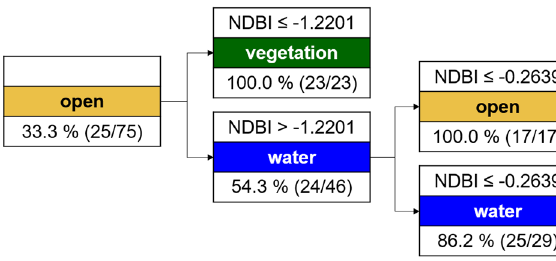
Figure A5. CART for June 2017.